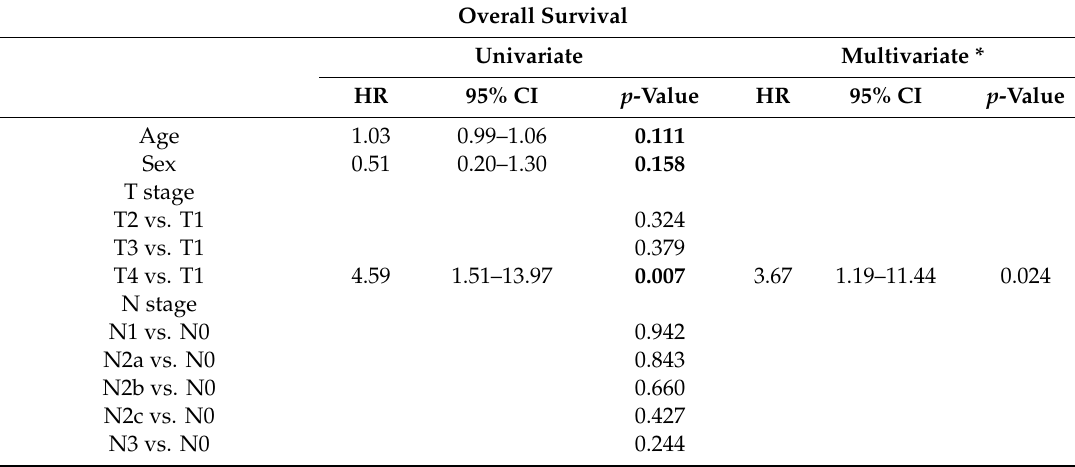
Figure 2. Survival outcomes for cohort of p16-positive (n = 192) disease comparing patients with or without RPLN involvement. Kaplan–Meier curves for ( A ) overall survival, ( B ) local (primary tumour) progression, ( C ) regional (lymph node) progression and ( D ) distant metastatic progression. RPLN negative (n = 171) in blue and RPLN positive (n = 21) in green. Table 3. Predictors of DMFS and OS in cohort with known p16 status (n = 226, including 27 patients with RPLN involvement): Cox proportional hazards regression analysis with stepwise selection of established prognostic factors. Factors included in analysis: age, sex, T and N stage, use of concurrent chemotherapy, smoking status and presence of RPLN and HPV status.